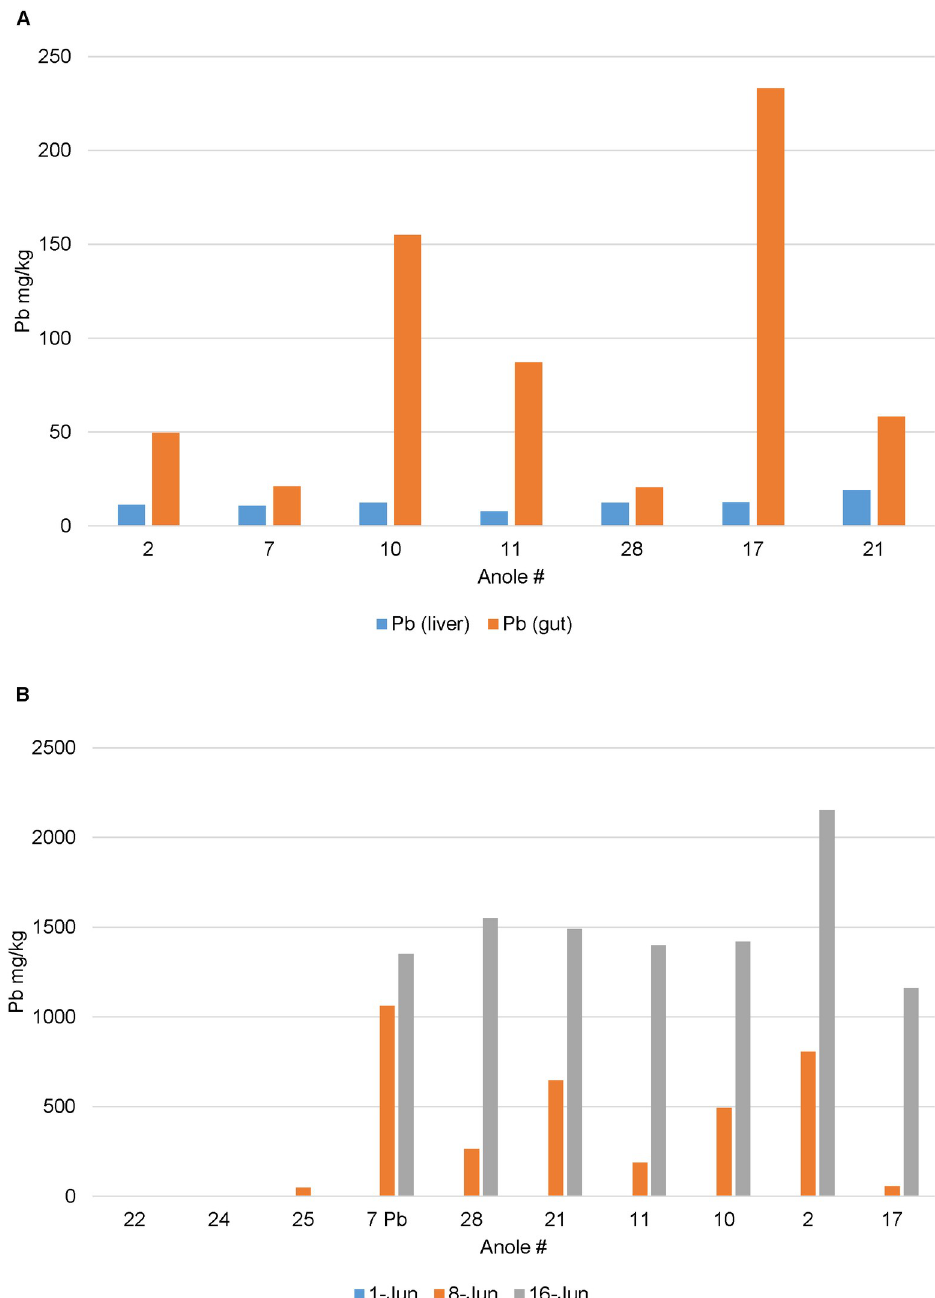
Fig 6. Analysis of lead in liver (A) and fecal (B) samples collected from anoles exposed to